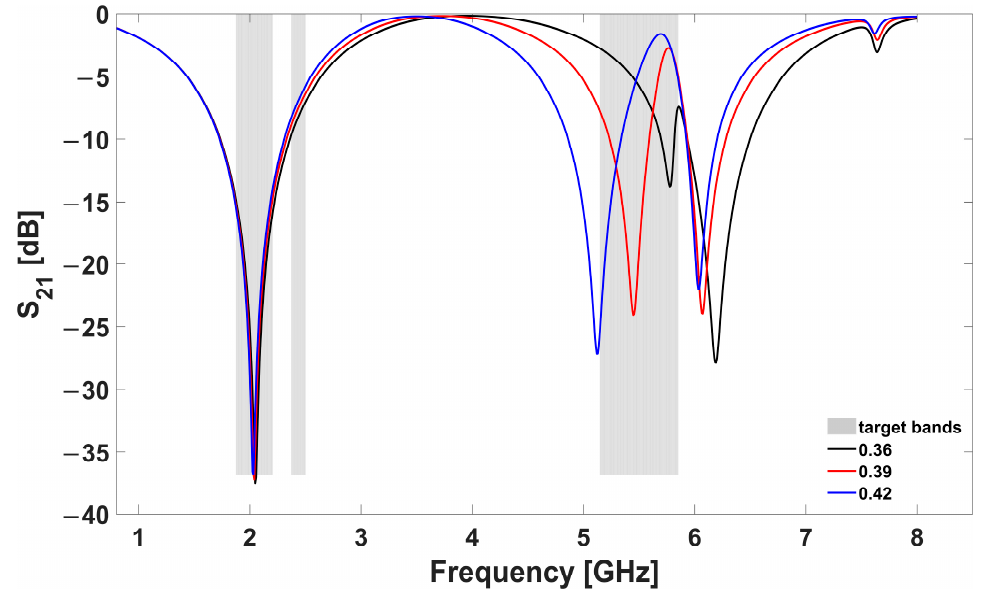
Figure 5. Simulated effect of the inner resonator.